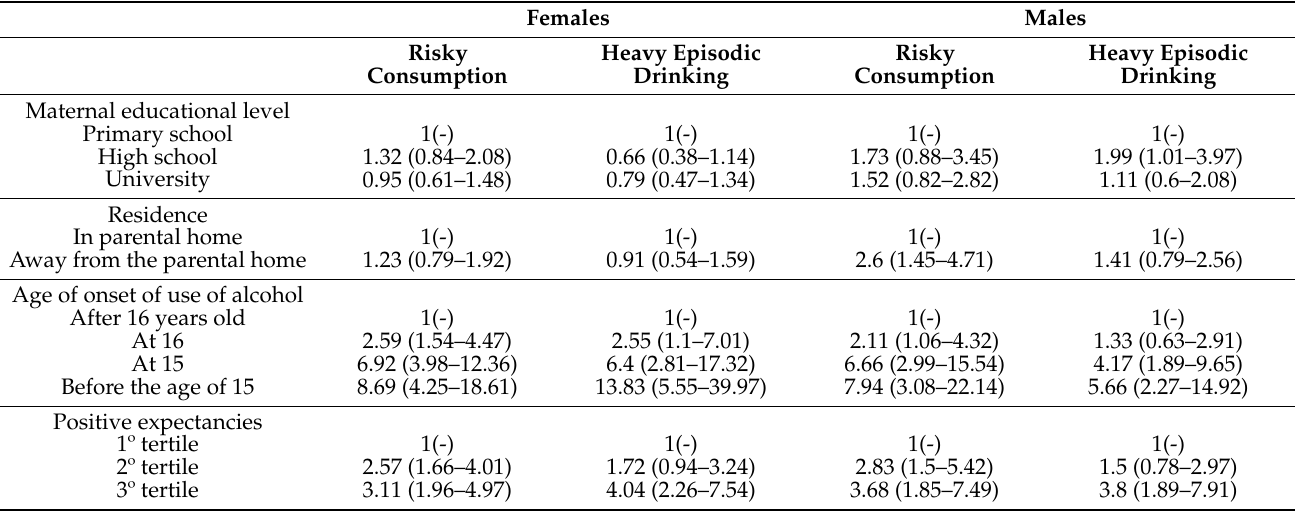
a Results of multivariate logistic regression adjusted for all variables included in the table. Table 4. Influence of explanatory factors on Risky consumption and Heavy episodic drinking among male and female students in 2012. Results are presented as adjusted odds ratio (95%CI) a .